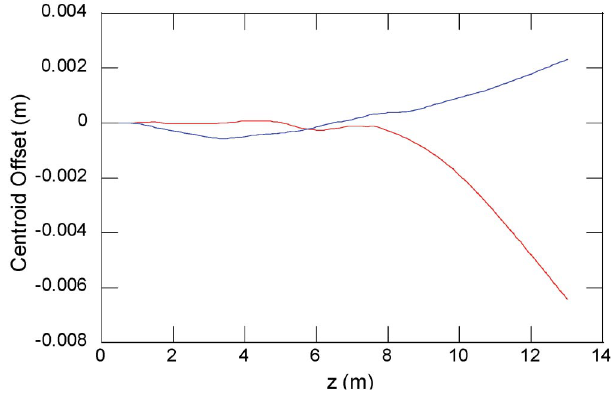
FIG. 32. (Color) Centroid of slice 800 (1.6 msec into pulse) versus distance for the commissioning geometry. The red line is for the horizontal centroid and the blue line is for the vertical